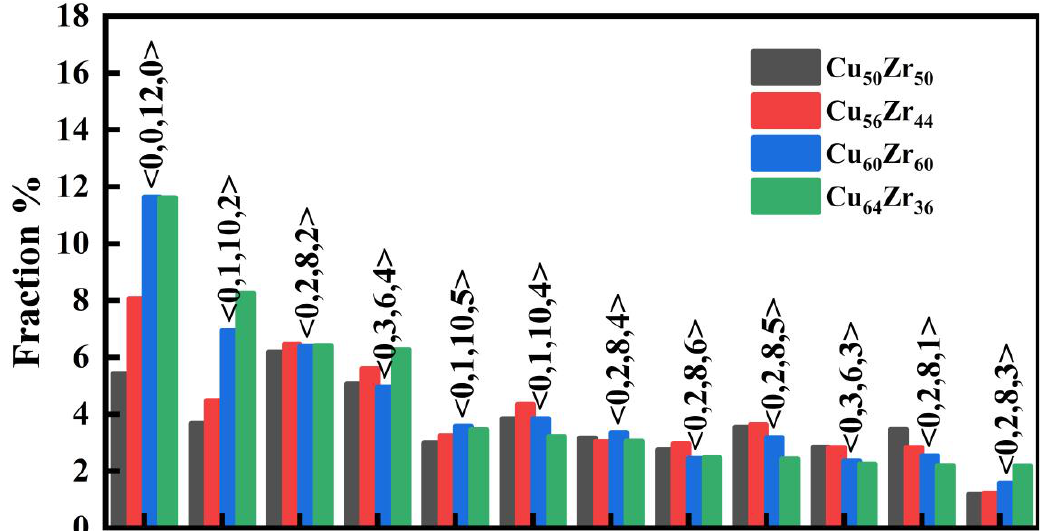
Figure 3. Frequency distribution of the 12 most frequent Voronoi polyhedron of Cu X Zr 100 − X (x = 50, 56, 60, 64) MGs.